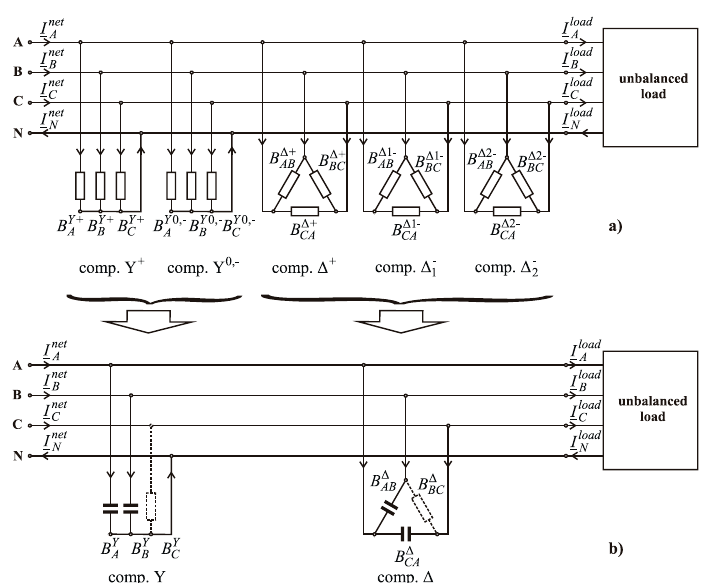
Figure 2. Electrical circuit of the five fictitious compensators ( a ) respectively of the two real compensators ( b ). Energies 2018 , 11 , x FOR PEER REVIEW